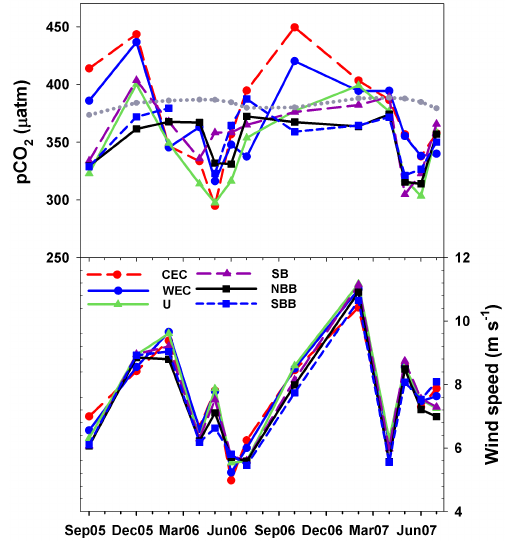
Fig. 7. Monthly mean calculated sea surface p CO 2 ( µ atm) for each region (upper plot with left axis), atmospheric p CO 2 data (µatm; dotted grey line in upper plot with left axis), and QuikSCAT wind speed data (ms − 1 ; lower plot with right axis). Central English Channel (dashed red line; circles); Western English Channel (blue line; circles); Ushant (green line; triangles); Shelf Break (dashed purple line; triangles); Northern Bay of Biscay (black line; squares); Southern Bay of Biscay (short dashed blue line; squares). Data points are linearly interpolated between sampling points to allow a clear distinction of observations between regions. It should not be assumed that the interpolation provides an accurate estimate of the missing